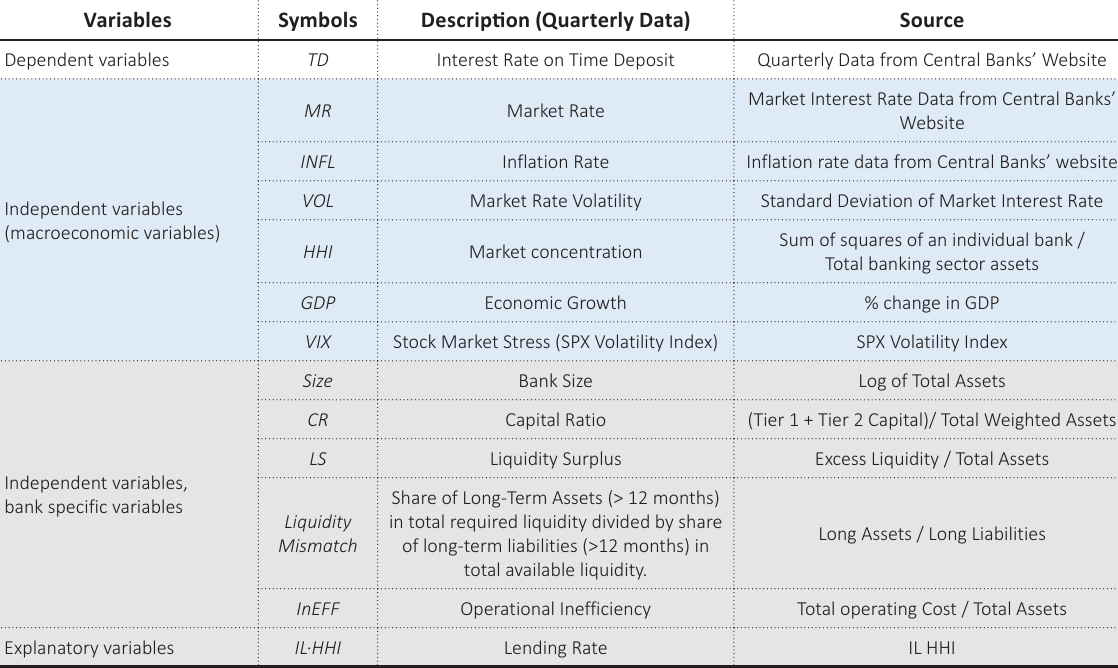
Table 2. Definition of variables from equation 2